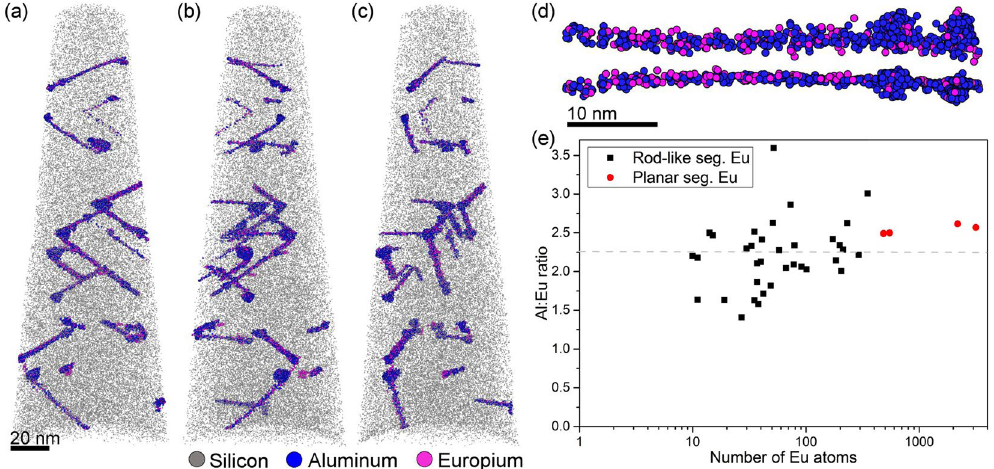
Figure 4. APT analysis of eutectic Si. ( a ), ( b ), and ( c ) are views of the same specimen at different rotation angles showing the scaffold of rod-like segregations in the Si lattice. ( d ) Shows one isolated rod-like segregation viewed from the top and the side. ( e ) Al:Eu ratios as a function of the number of Eu-atoms in each of the 39 clusters (35 rod-like and 4